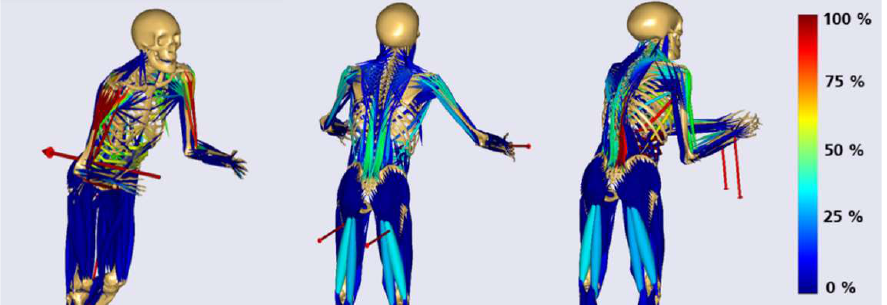
Figure 4. Musculoskeletal models in high loaded static postures with visualization of muscle activation (left: pushing, middle: pulling and right: lifting), the models are shown with external body forces as red arrows in the representative posture for the three application scenarios.